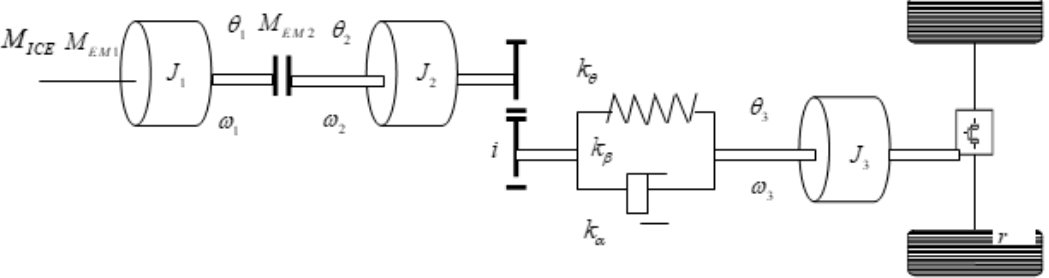
Figure 2. Simplified structure of the parallel